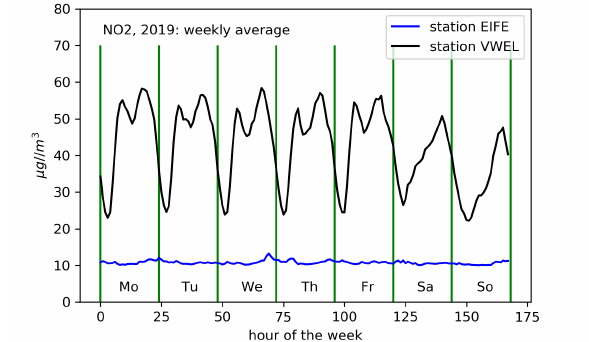
Figure 1. Weekly average values of NO 2 (year 2019) for the urban station VWEL (high volume of traffic) and the rural station EIFE (surrounded by vegetation, no buildings, low traffic).